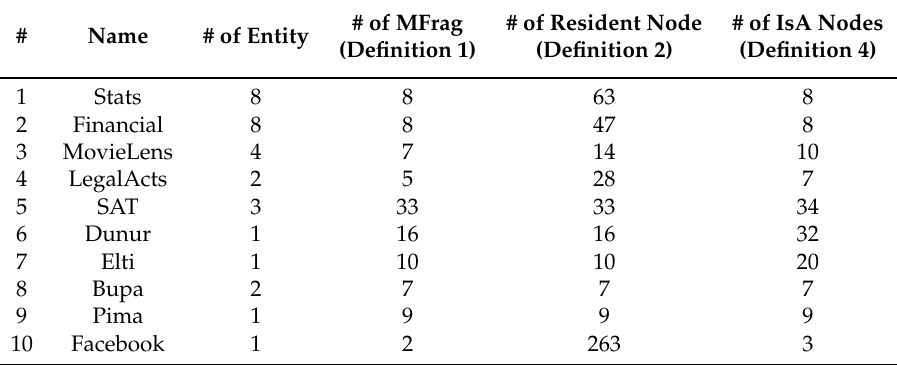
Table 5. 10 Real-World Relational Databases with Elements of Its Mapped